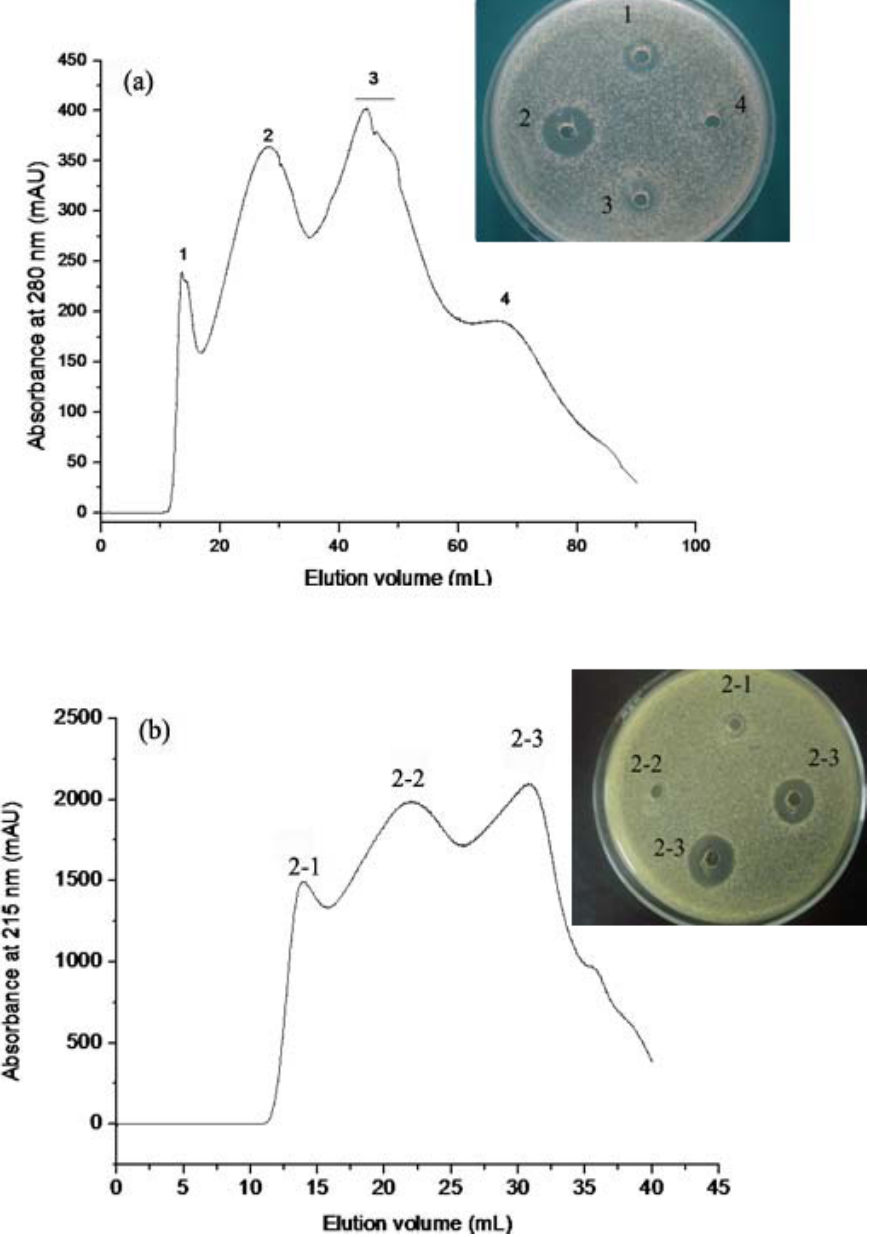
Figure 1. Chromatogram profiles and antibacterial activity of fractions isolated by Sephadex G-25 gel. ( a ) Eluted with 50 mM sodium phosphate buffer in 0.15 mol/L NaCl (pH 5.8) at a flow rate of 1.0 mL/min. ( b ) Eluted with deionized water at a flow rate of 0.5 mL/min. Numbers beside the wells were corresponding to the peak numbers in chromatographic